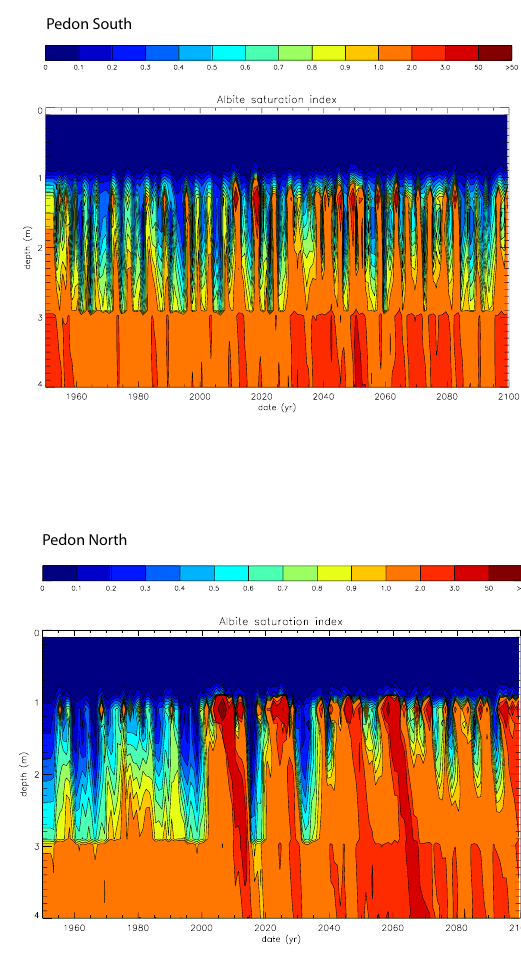
Fig. 4. Calculated time evolution of the saturation state of the soil Figure 4 solutions with respect to albite, plotted as a function of depth: (a) southern pedon, (b) northern